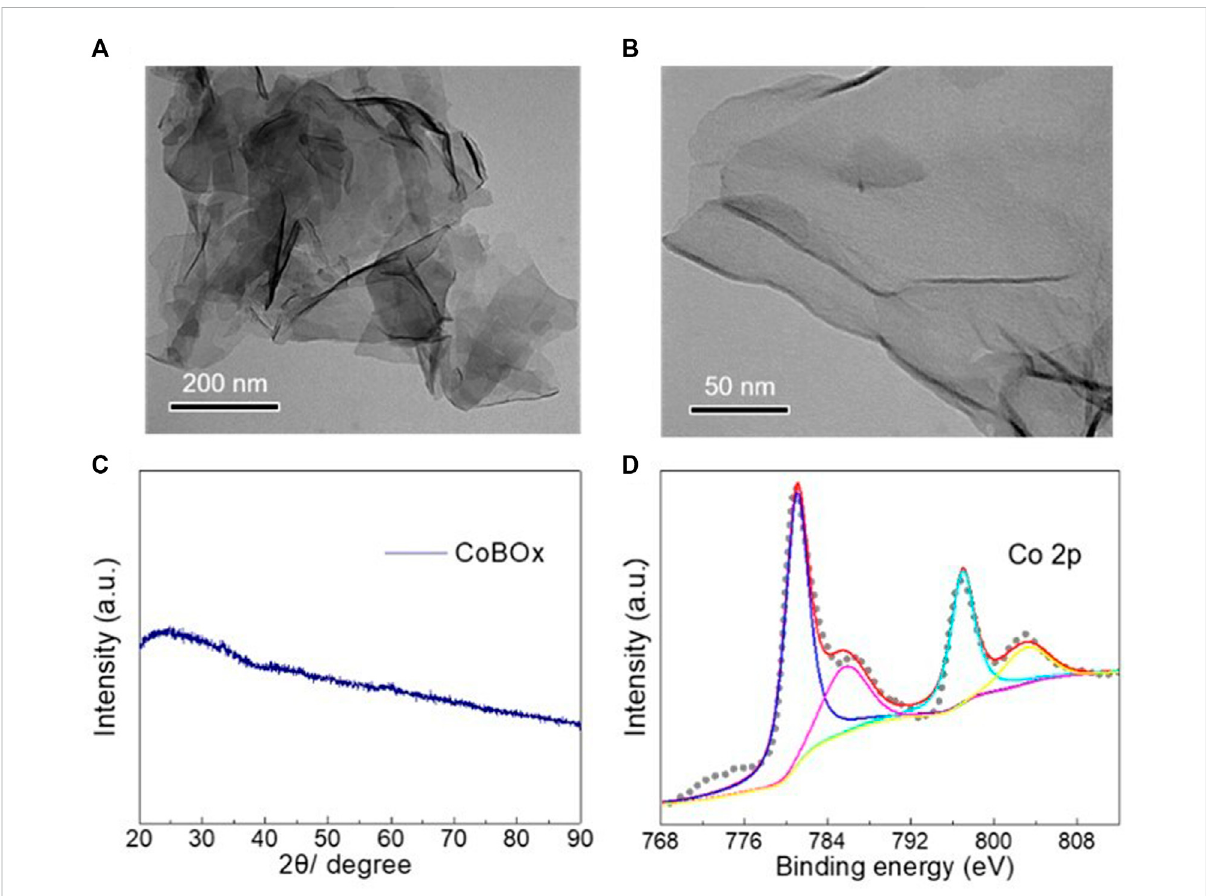
FIGURE 1 Characterizations of the fresh CoBO x catalysts. (A,B) TEM images of the CoBO x nanosheets with different magni fi cation times. (C) XRD pattern and (D) XPS spectrum of Co 2p of the CoBO x